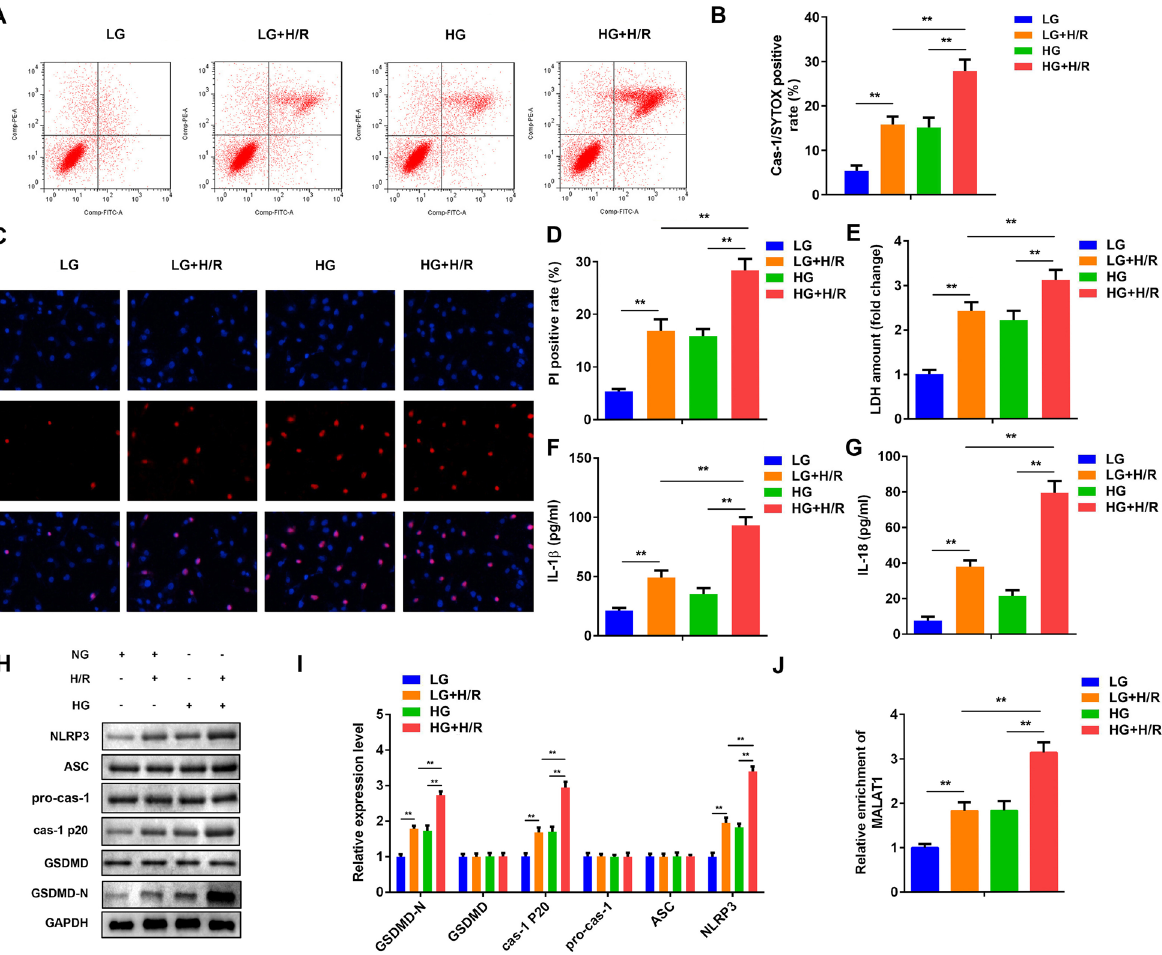
Fig. 3 High glucose treatment aggravated cytotoxicity and pyroptosis of the H/R BV2 cells. A , B 72 h after the indicated treatment, BV2 cells were labelled with caspase-1 antibody and SYTOX, and counted by flow cytometry. C , D The cells were stained by PI and DAPI 72 h after the indicated treatment. PI positive rate was expressed as the proportion of PI positive cells (red) in the DAPI positive cells (blue). E LDH concentration of the BV2 cells were measured by ELISA kit 72 h after indicated treatment. The concentrations of IL-18 ( F ), and IL-1β ( G ) in the BV2 cells were measured by ELISA kit. H , I Western blot for GSDMD-N, GSDMD, caspase-1 p20, pro-caspase-1, ASC and NLRP3 of the BV2 cells 72 h after they received indicated treatment. The optical density (OD) of protein bands was indicated relative to corresponding loading control GAPDH. J MALAT1 levels were measured by RT-qPCR 72 h after the indicated treatment. (n 6), ** P < 0.01, OGD/R, oxygen–glucose =